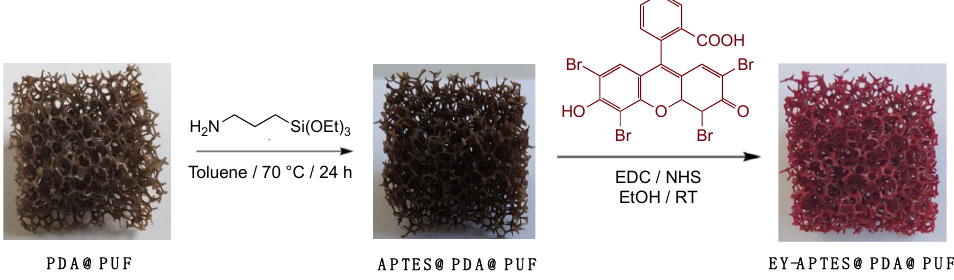
Figure 1. Post-functionalization strategy of PDA@PUF for eosin Y immobilization.